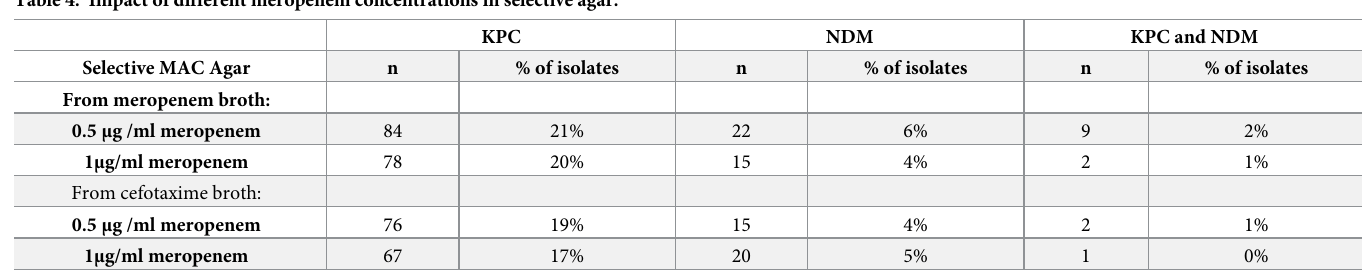
Table 4. Impact of different meropenem concentrations in selective agar.